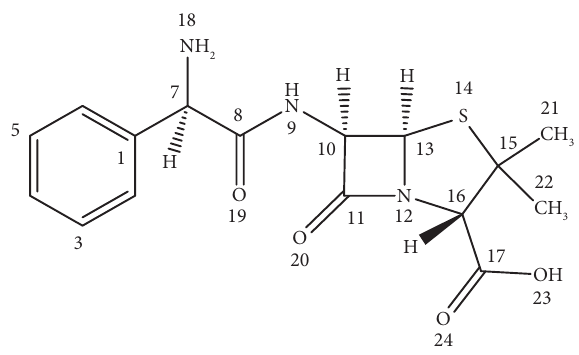
Figure 1: Molecular structure of